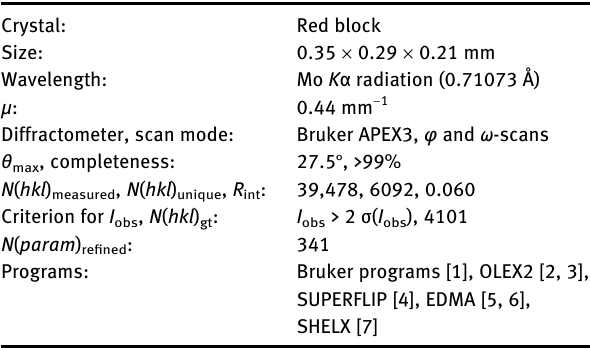
Table  : Data collection and